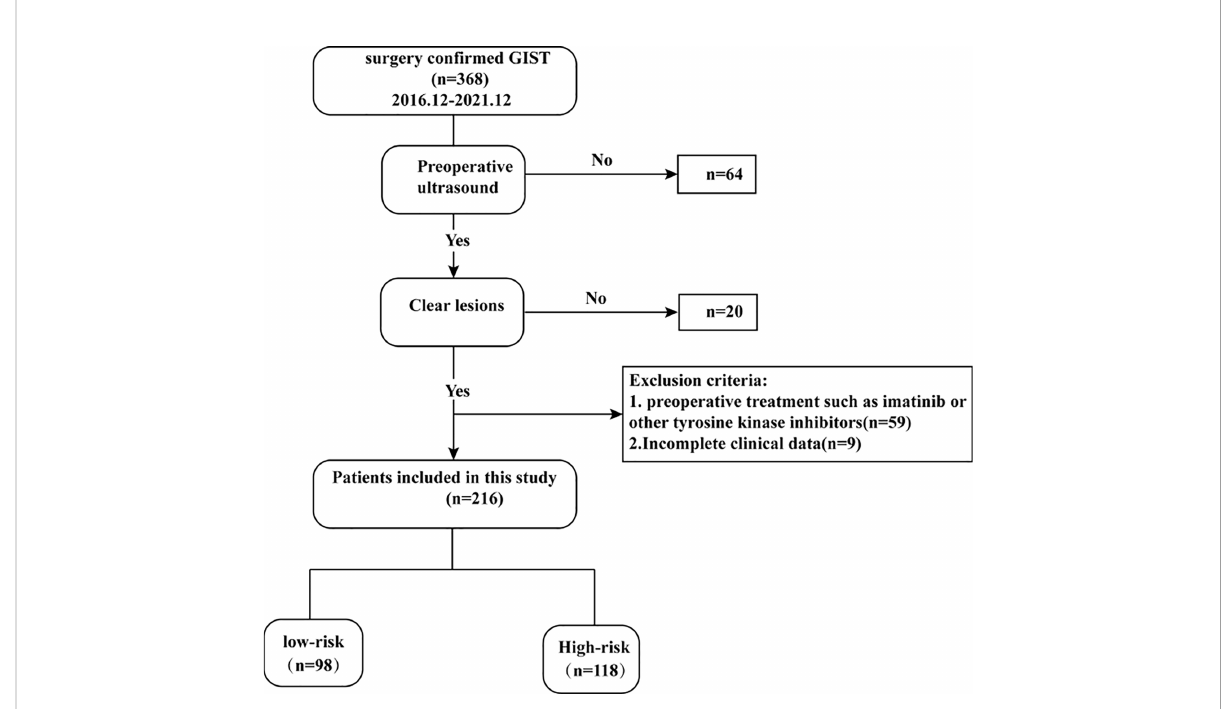
FIGURE 1 Flowchart of inclusion and exclusion of the study